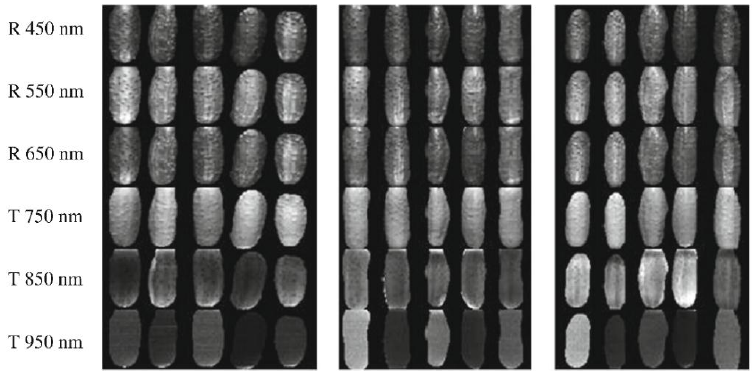
Figure 17. Hyperspectral images of normal and defective pickling cucumbers, where R and T represent reflectance and transmittance, respectively. Reproduced with permission from [87], Copyright Springer, 2014.